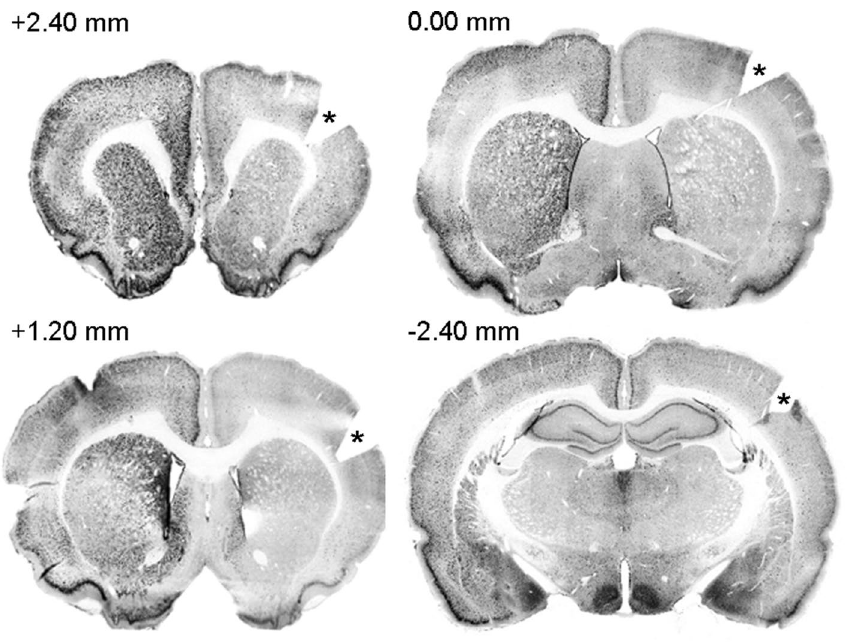
Figure 6. Left hemisphere-wide elevated c-Fos expression at different positions with respect to bregma. One representative animal is shown, but all STIM rats had a similar general pattern. Blackness represents c-Fos expression. Right hemispheres are depicted on the right side and marked by a slit (*) in the